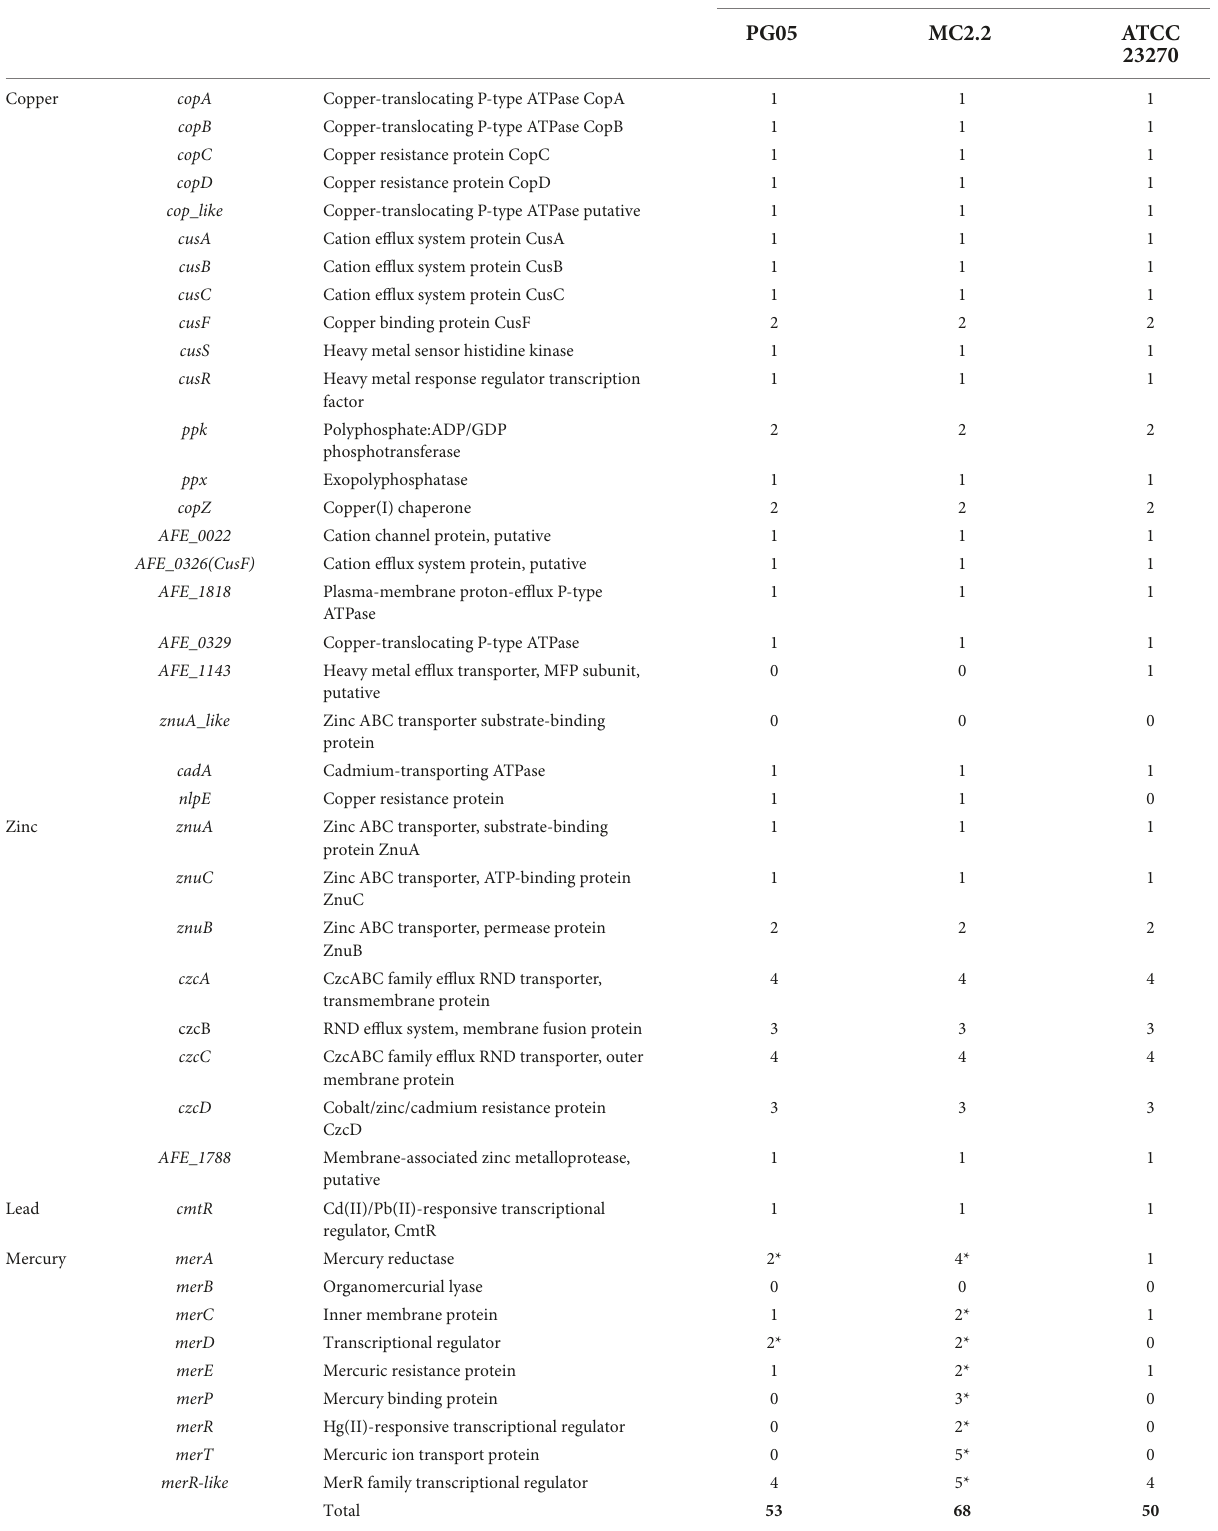
TABLE 6 Genes associated with metal tolerance identified in the PG05 and MC2.2 strain genomes compared to the type strain ATCC 23270. Metal Gene Product Acidithiobacillus ferrooxidans PG05